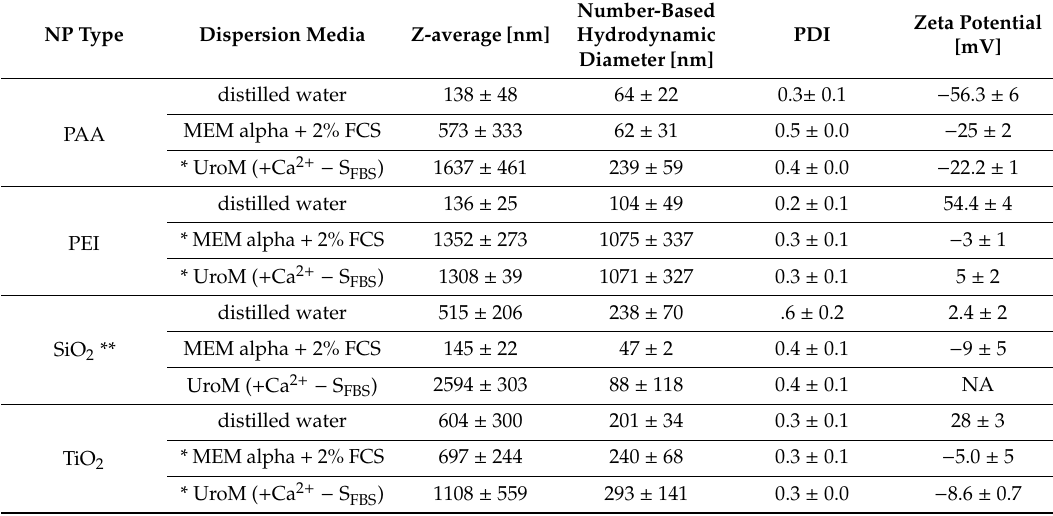
Table 1. Measured z-average size (by %Intensity), number-based hydrodynamic diameter (by %Number), polydispersity index (PDI), and zeta potential for polyacrylic acid (PAA), polyethylenimine (PEI), SiO 2 , and TiO 2 nanoparticles (NPs) in distilled water and cell culture media used in the study.